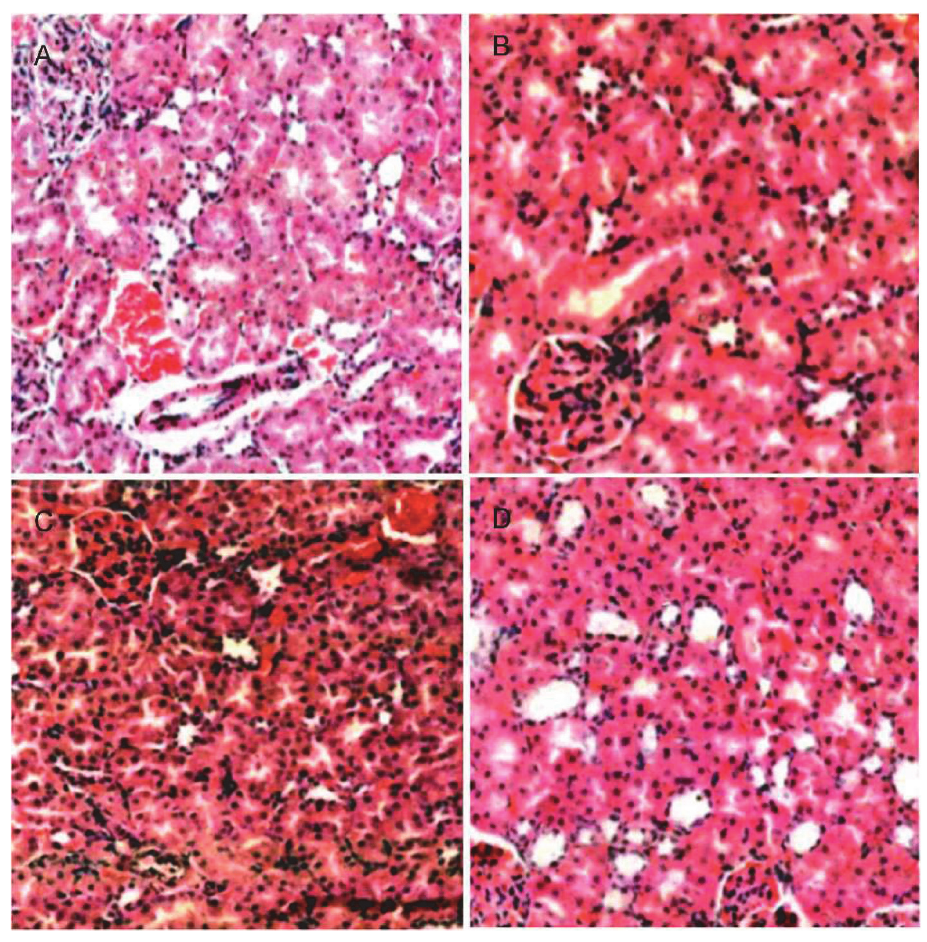
Fig. 3. H&E staining results of kidney tissue